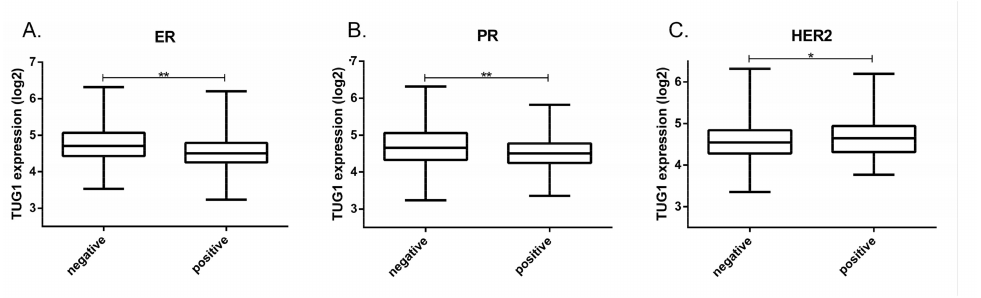
Figure 2. TUG1 transcript expression associated with breast cancer relevant receptors; ( A ) TUG1 expression in positive ( n = 385) or negative ( n = 114) estrogen receptor (ER); ( B ) TUG1 expression in positive ( n = 328) or negative ( n = 170) progesterone receptor (PR); ( C ) TUG1 expression in positive ( n = 74) or negative ( n = 413) HER2. TUG1 expression data were from TCGA. * p = 0.001; ** p < 0.0001. ER, estrogen receptor; PR, progesterone receptor.